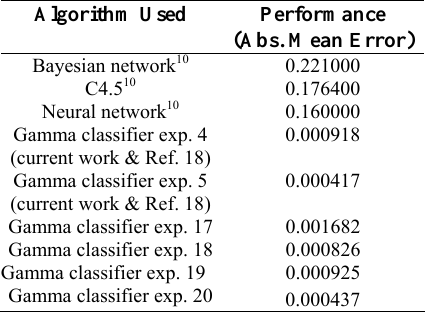
Table 9. Comparison of related results (SIMAT database, O 3 ) in absolute mean error given for pollutant concentration in ppm; exp. means